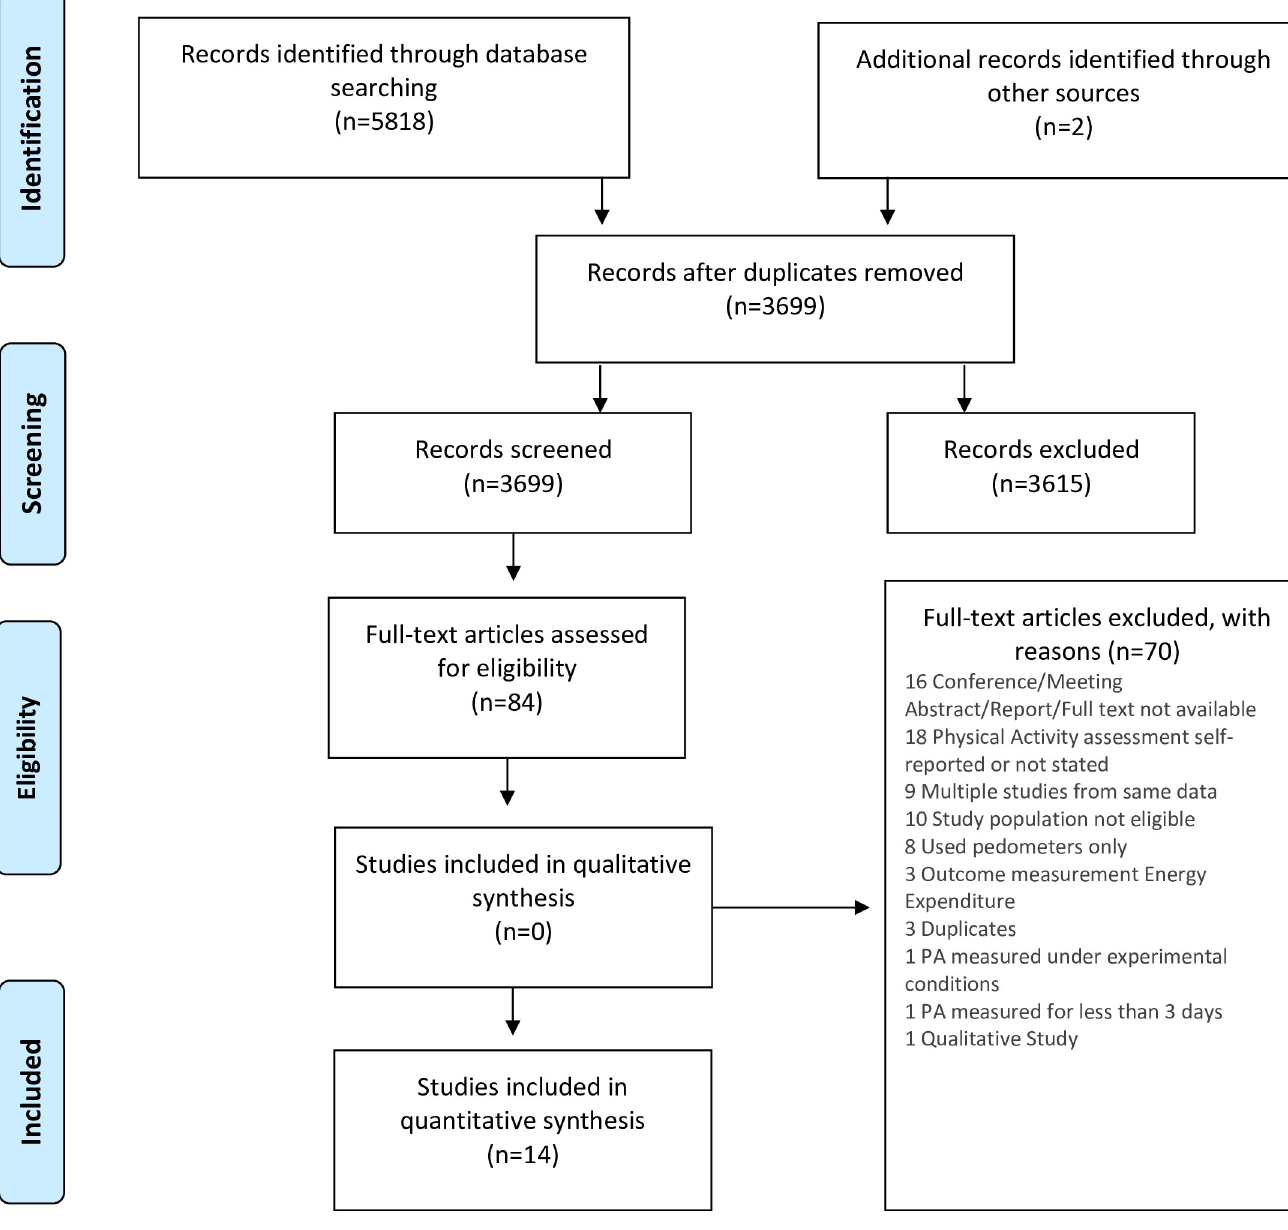
Fig 1. Flow diagram of studies considered for inclusion in the systematic